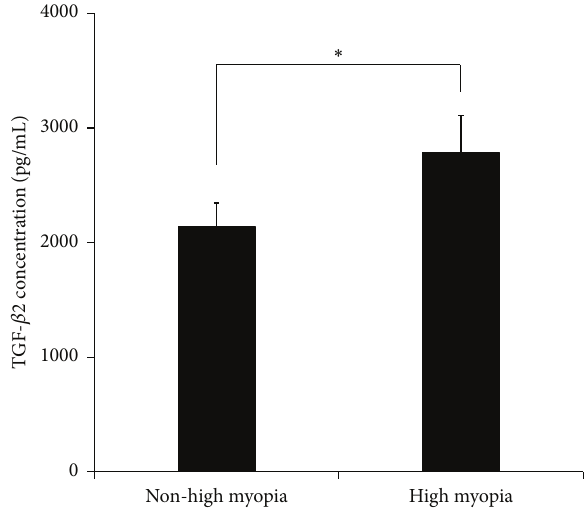
Figure 3: TGF- 𝛽 2 concentration in aqueous humor of capsular con- traction syndrome. ELISA results showed significantly higher levels of average TGF- 𝛽 2 in the aqueous humor of CCS patients with high myopia than in CCS patients with ARC ( 𝑃 < 0.001 , 𝑡 -test). ELISA = enzyme-linked immunosorbent assay; TGF- 𝛽 2 = transforming growth factor- 𝛽 2; CCS = capsular contraction syndrome.